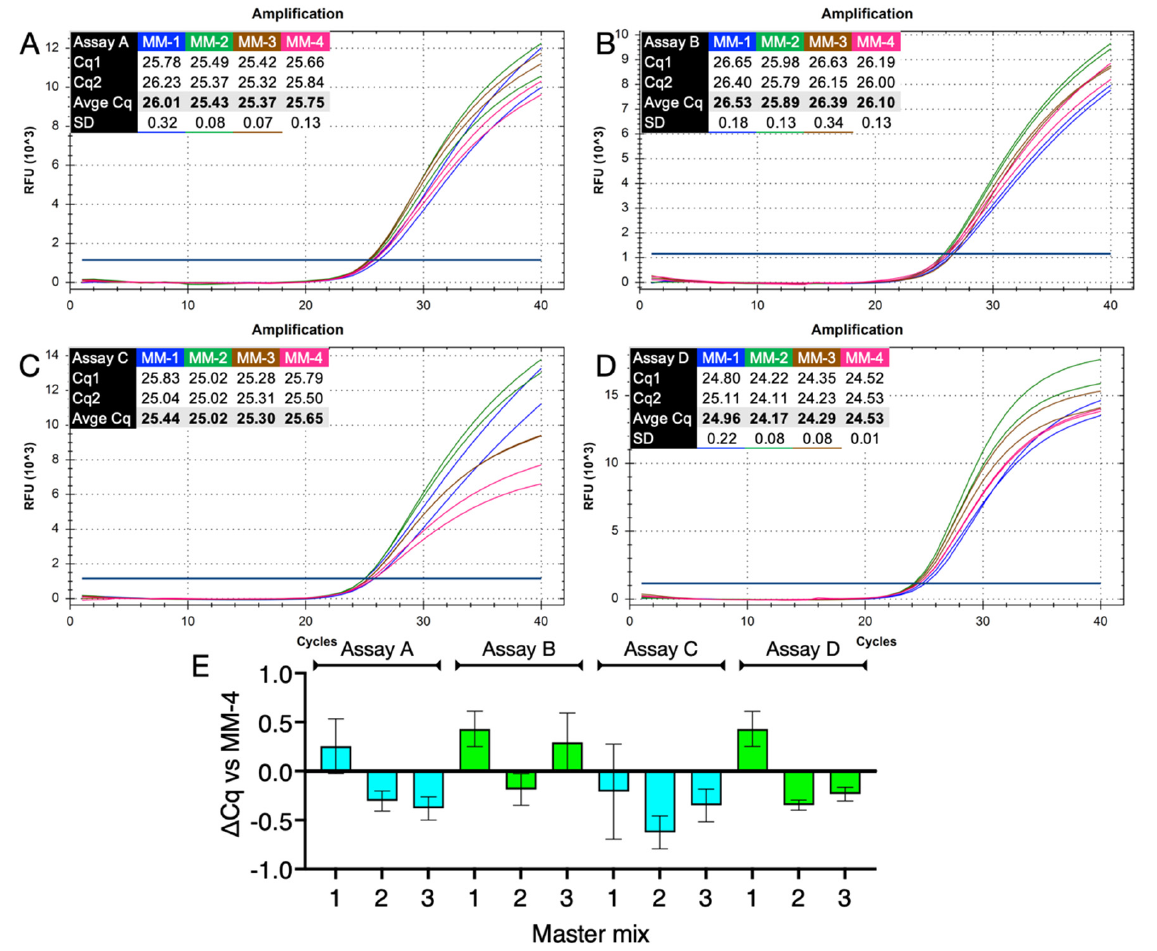
Figure 2. Amplification by MM-1 to MM-4 using standard PCR conditions (2 min activation at 95 °C, followed by 40 cycles of 5 s at 95 °C denaturation and 20 s at 60 °C annealing/polymerisation steps). MM-1 (blue), MM-2 (green), MM-3 (brown), MM-4 (pink). Assays A and D were detected by an LNA probe, assays B and C by a DNA probe. ( A ). Amplification plots and Cq values assay A (437 bp). ( B ). Amplification plots and Cq values assay B (348 bp). ( C ). Amplification plots and Cq values assay C (234 bp). ( D ). Amplification plots and Cq values assay D (153 bp). ( E ). ∆ Cq values (±SD) for past expiry date MM-1 to 3 relative to the current MM-4.